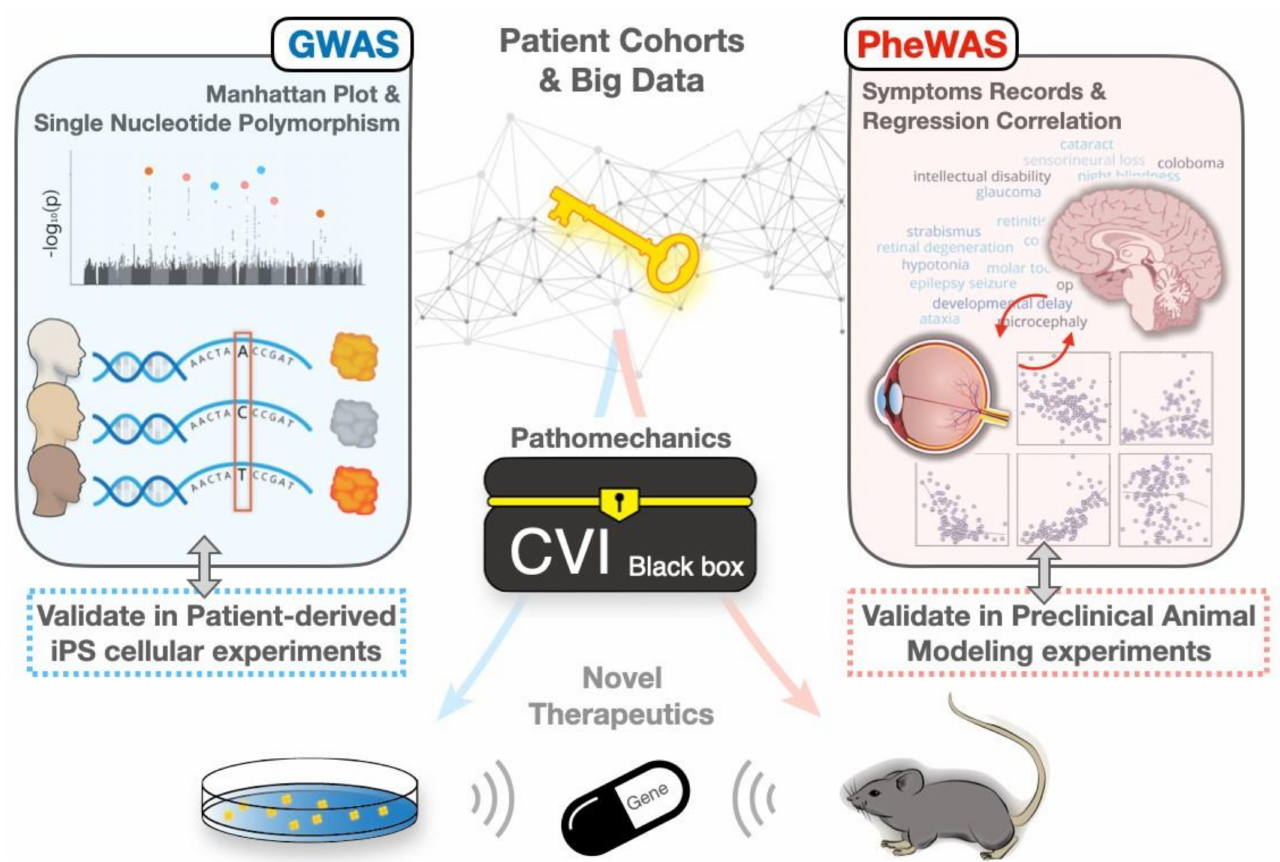
Figure 2. Revisiting cerebral visual impairments (CVIs) by genome-wide and phenome-wide as- sociation studies (GWAS and PheWAS). Cerebral visual impairments result from hidden common pathomechanisms. With the transactions between GWAS and PheWAS, hidden pathologies could be revealed and further proved by studies in induced pluripotent stem (iPS) cell and animal models, which could stimulate the inventions of novel